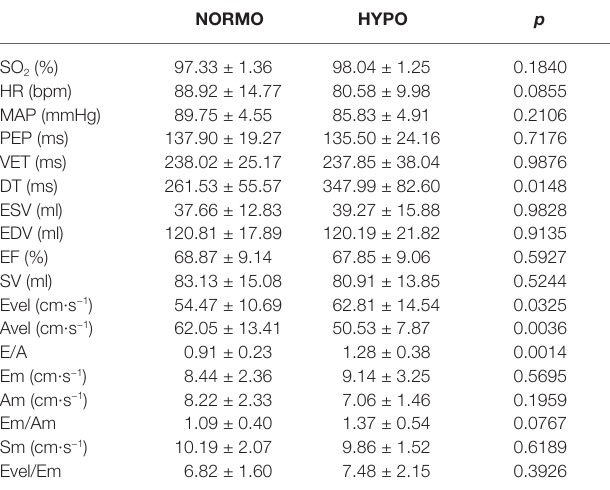
TABLE 2 | Hemodynamic values during the third minute of rest preceding the test in normoxia (NORMO) and in hypoxia with FiO 2 at 13.5% (HYPO). N = 12.